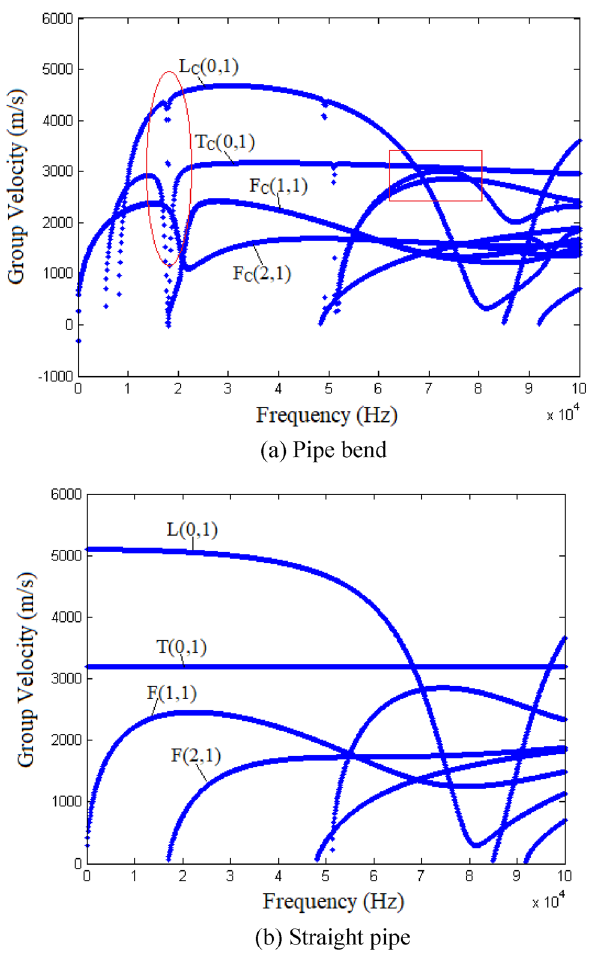
Figure 2. Group-velocity dispersion curves for ( a ) a pipe bend and ( b ) a straight